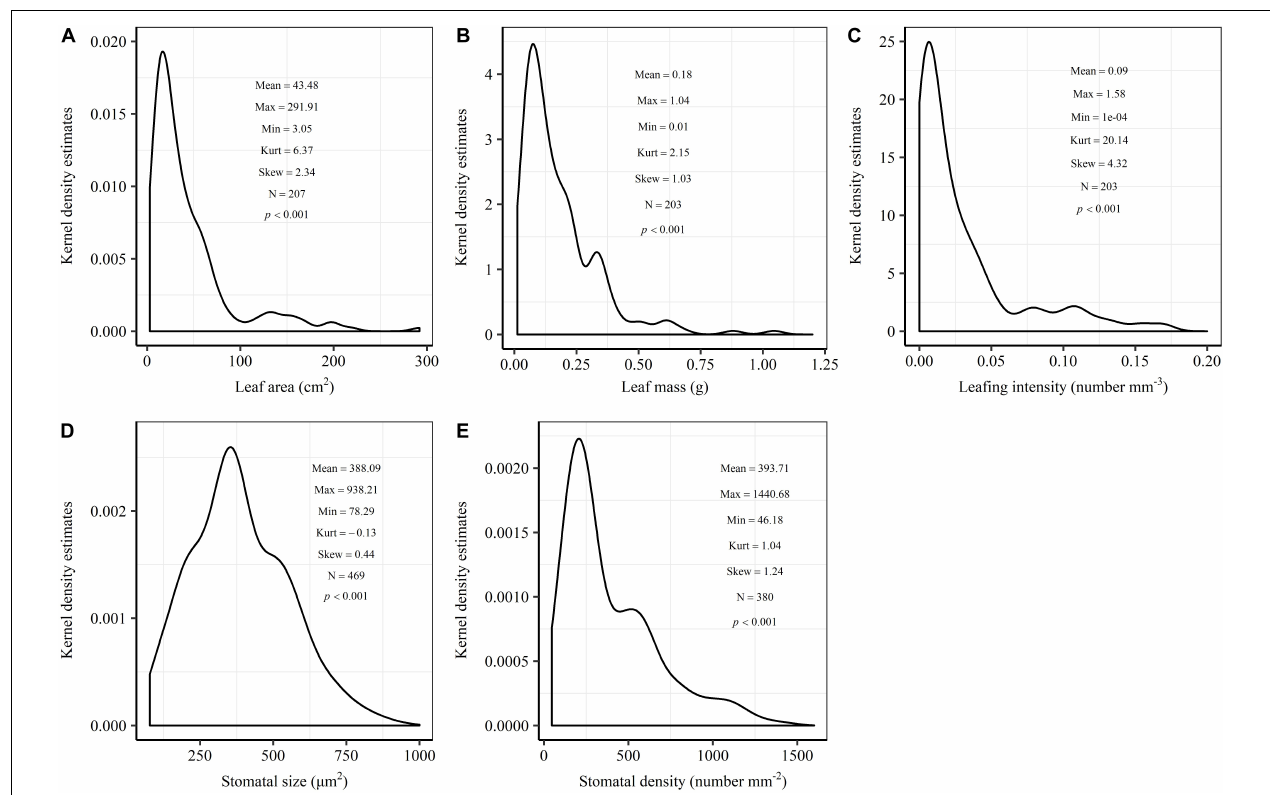
FIGURE 1 | Kernel density estimates of individual leaf area (A) , individual leaf mass (B) , leafing intensity (C) , stomatal size (D) and stomatal density (E) . The y-axis indicates the abundance of leaf and stomatal traits with a given value. The mean, maximum (Max), minimum (Min), kurtosis (Kurt), skewness (Skew) and sample size (N) were shown in the insets. The frequency distribution was significant different from normal distribution at p < 0.05.